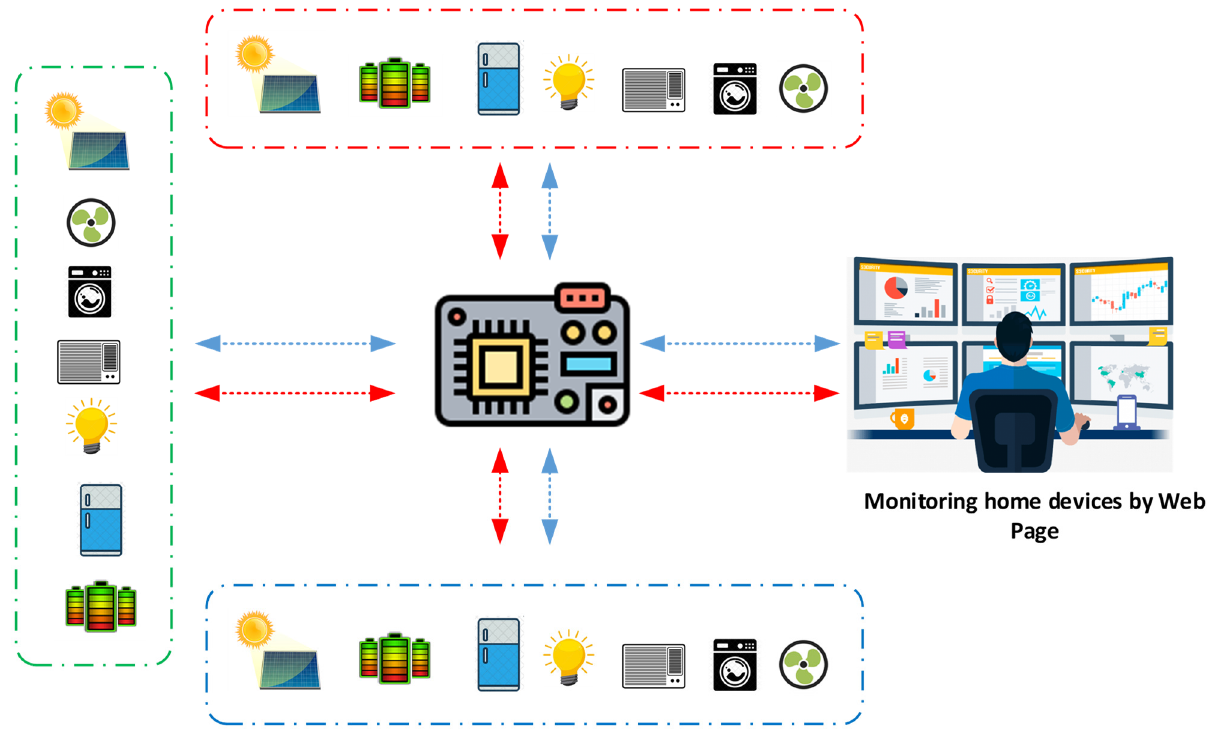
Figure 1. The components of the proposed smart grid scheme.